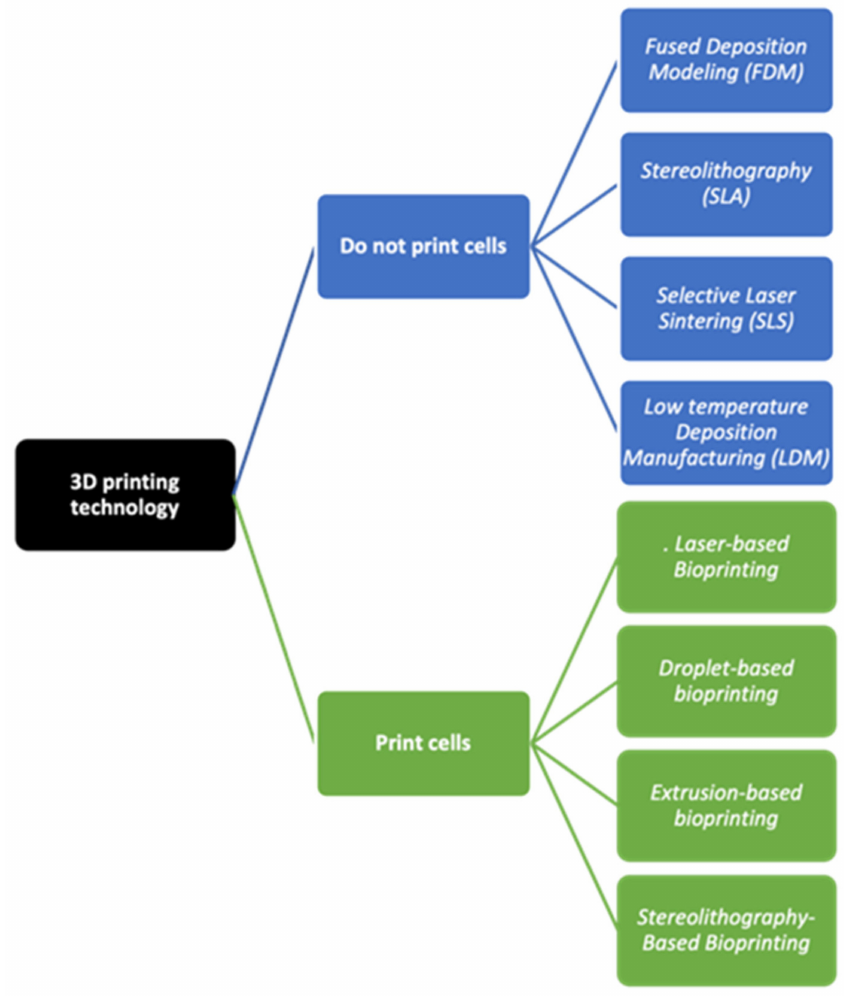
Figure 1. The 3D bioprinting